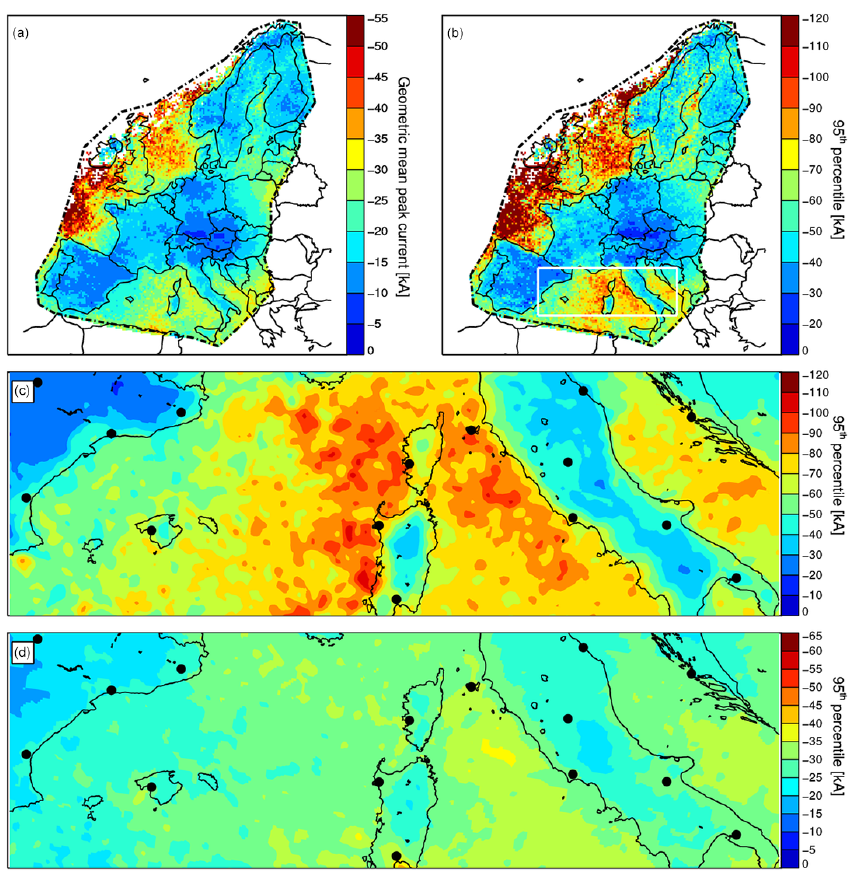
Figure 7. Distribution of (a) geometric mean, and (b) 95th percentile of the peak current [kA] from first strokes in negative flashes, based on 2006–2014 EUCLID data and adopting a spatial resolution of 20km × 20km. (c) Zoomed-in view as outlined by the white box in (b) , smoothed by a Gaussian filter for clarity. (d) Same as (c) , but for subsequent strokes. In addition, the sensor locations are indicated in (c) and (d) .